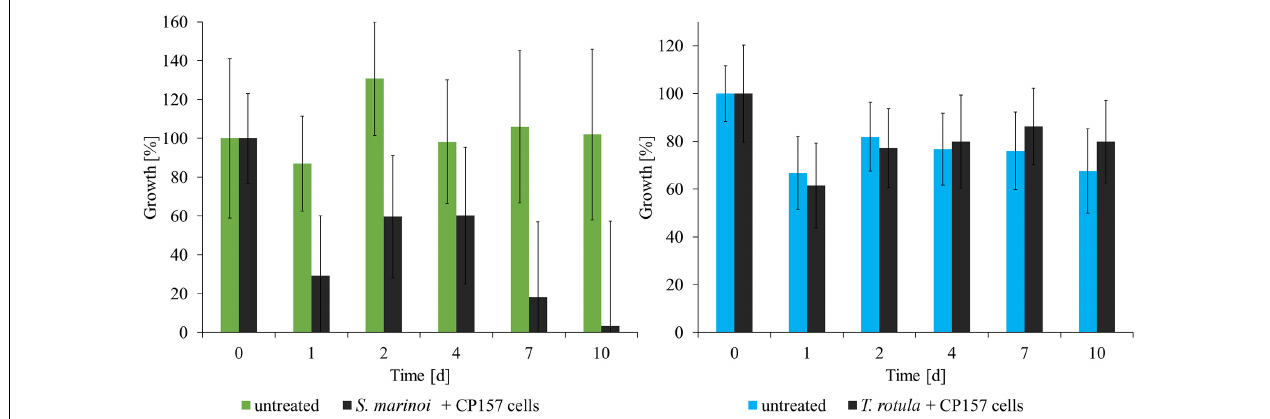
FIGURE 2 | Response of microalgae to co-cultivation with CP157 (black) and comparison with untreated cultures of Skeletonema marinoi (green) or Thalassiosira rotula (blue). Growth was determined by measuring relative fluorescence over time. Changes are expressed as percentage relative to the fluorescence measured at t 0 . Values are means ± standard deviation ( n = 3).